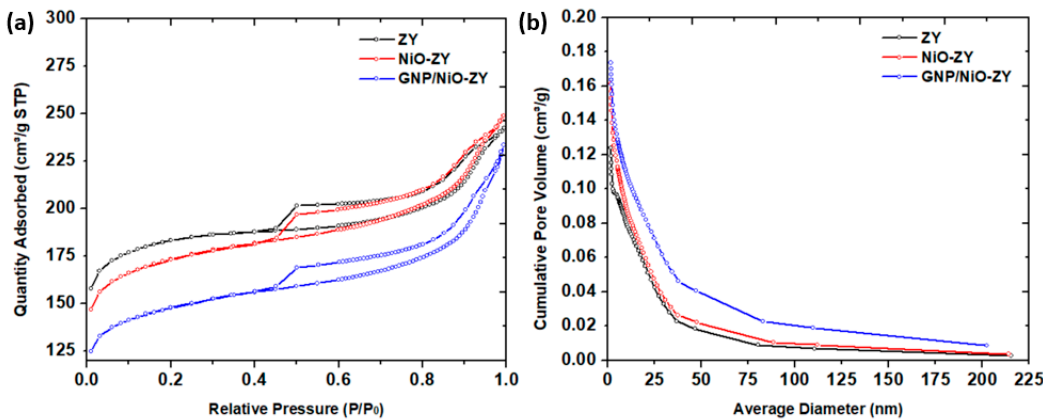
Figure 1. ( a ) N 2 adsorption–desorption isotherms and ( b ) Barrett, Joyner, and Halenda (BJH) pore size distribution for ZY, NiO-ZY, and GNP /